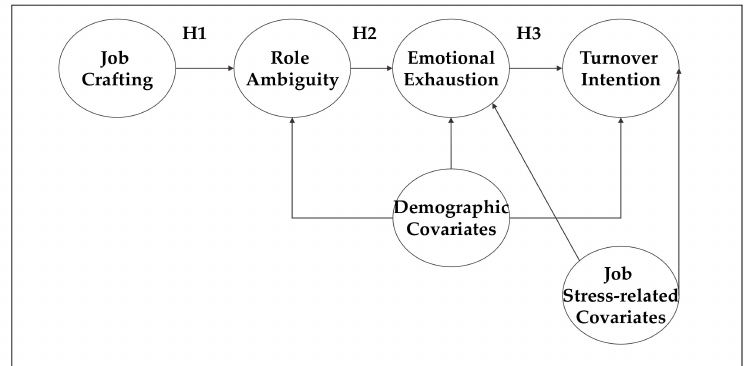
Figure 1. Proposed research model and research